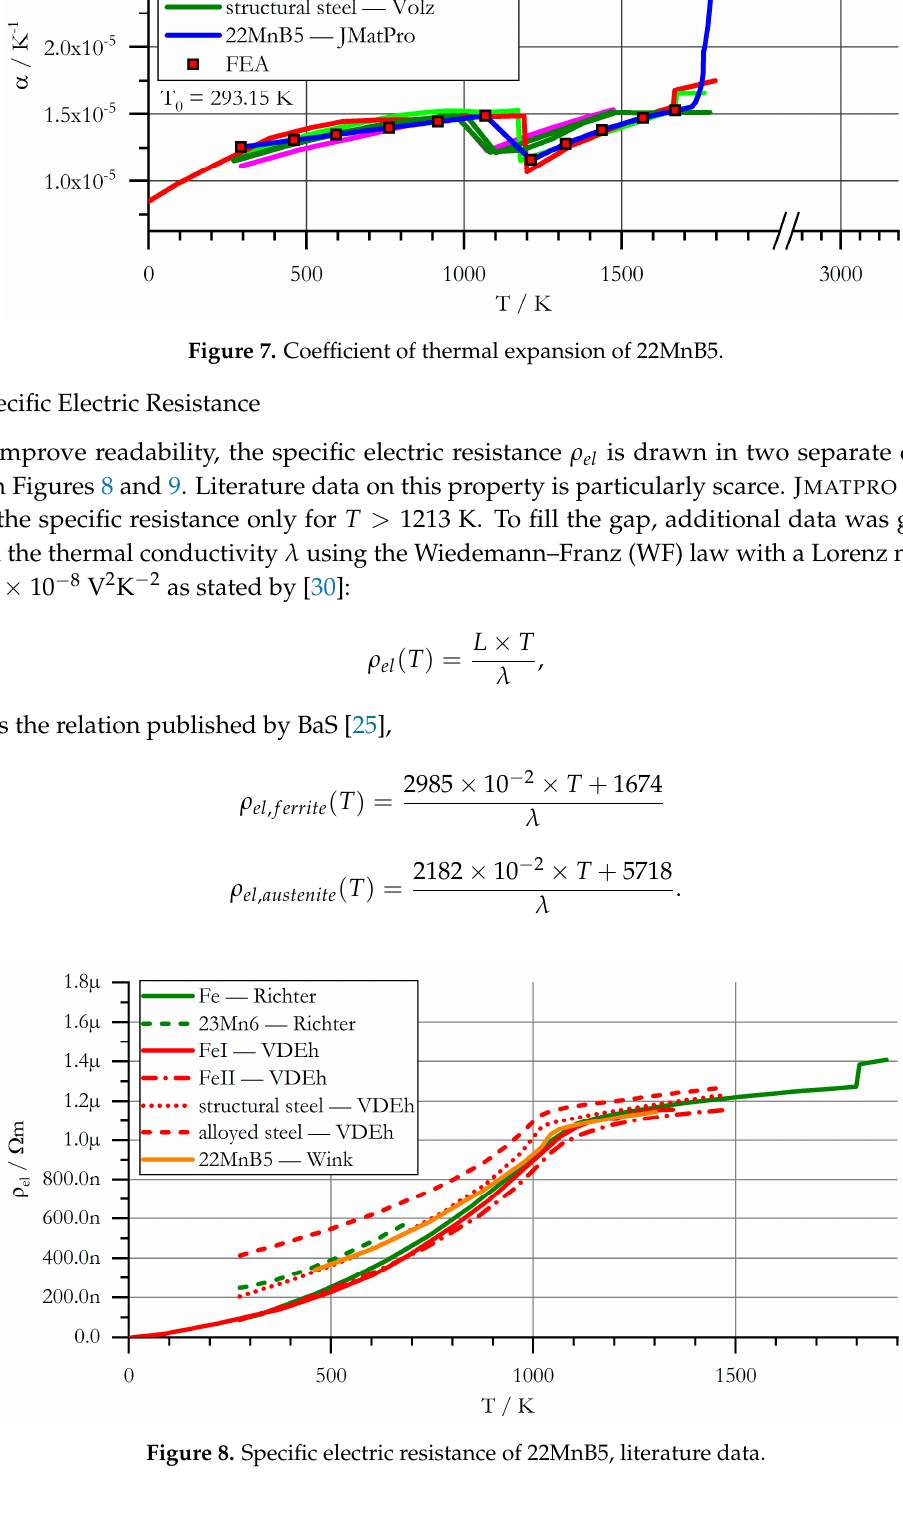
Figure 8. Specific electric resistance of 22MnB5, literature data.